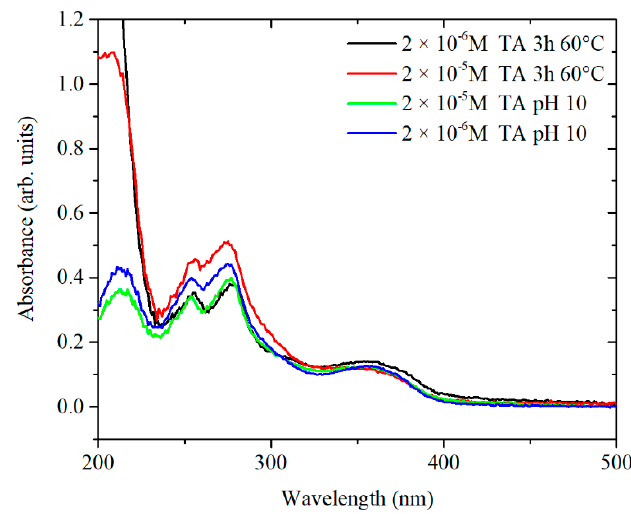
Figure 9. Comparative UV-vis spectra of TA thermally preconditioned at 60 ◦ C and equilibrated overnight at pH